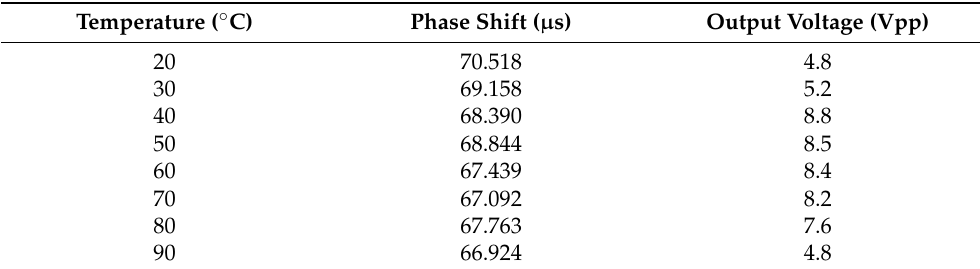
Table 1. Results of the effects of temperature change